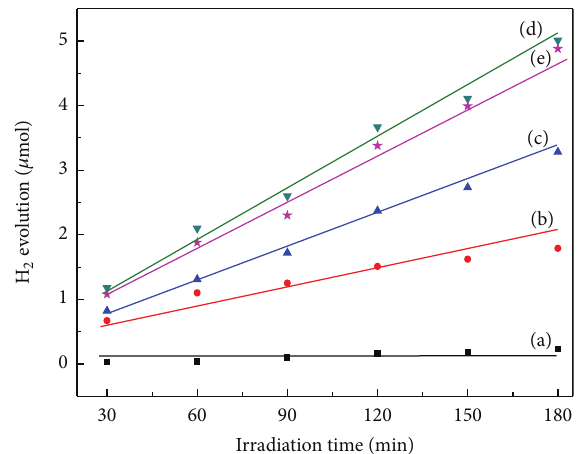
Figure 7: Time course of hydrogen evolution under UV-vis light irradiation. (a) P25, (b) C/TiO 2 , (c) 0.1 wt% Pt-C/TiO 2 , (d) 0.4 wt% Pt-C/TiO 2 , and (e) 0.6 wt% Pt-C/TiO 2